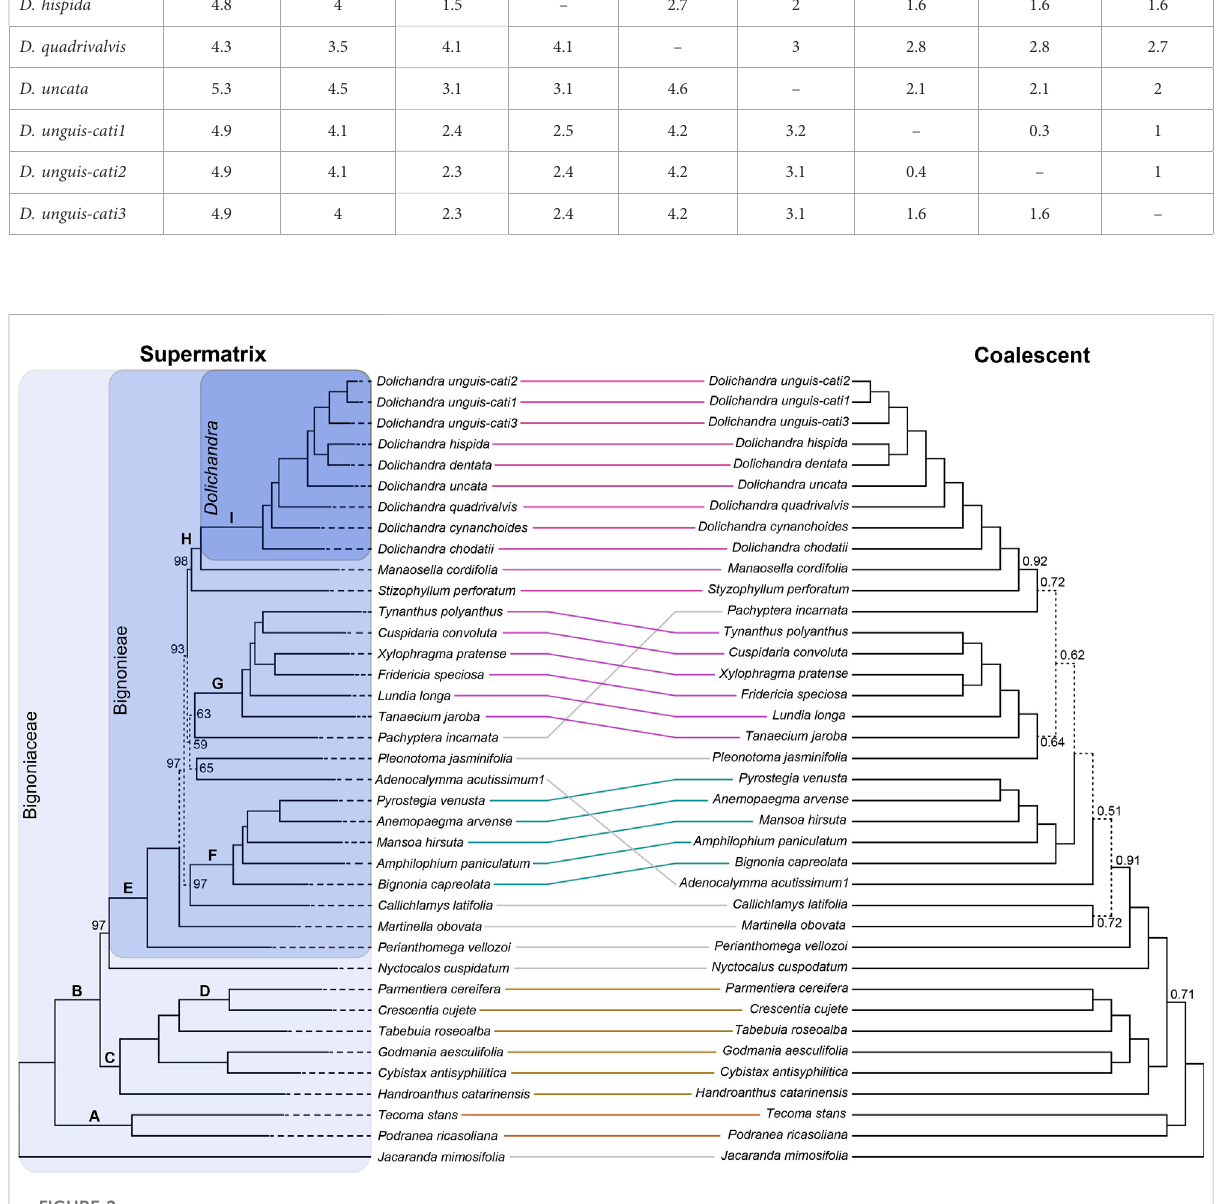
FIGURE 2 Tanglegram comparisons of phylogenies obtained using a supermatrix approach and IQ-TREE, and a coalescent approach and ASTRAL-III of theExon-Onlydataset.Thesupermatrixresultincludesultra-fastbootstrapproportion(UFBoot)supportvalues.Thecoalescentresultislabeledwith local posterior probabilities (LPP). Values above branches with maximum support of the UFBoot and LPP are not shown. Branches labeled on the supermatrix tree are discussed in the text. Shaded boxes enclose the entire Bignoniaceae family; the tribe Bignoniaeae; and the genus Dolichandra